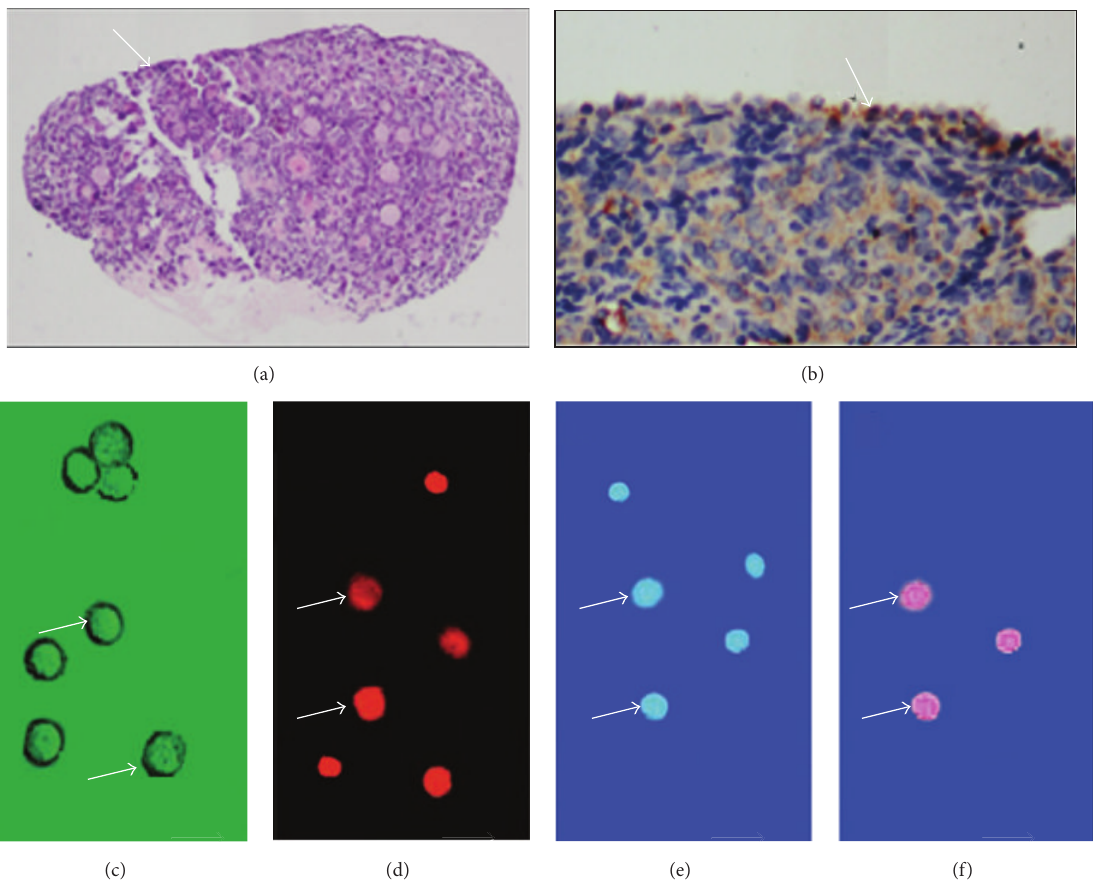
Figure 1: The isolation and identification of putative FGSCs. (a) H&E stained from histological ovaries sections: putative FGSCs have been considered to be mainly localized in ovarian cortex. (b) IHC results: putative FGSCs were detected by stem cell marker Oct-4 antibody. (c) Putative FGSCs were isolated by primary culture method. Arrows: the freshly isolated putative FGSCs. (d) Arrows: the isolated MVH + putative FGSCs. (e) Green: the isolated BrdU + cells. (f) The merger of (d) and (e) by dual